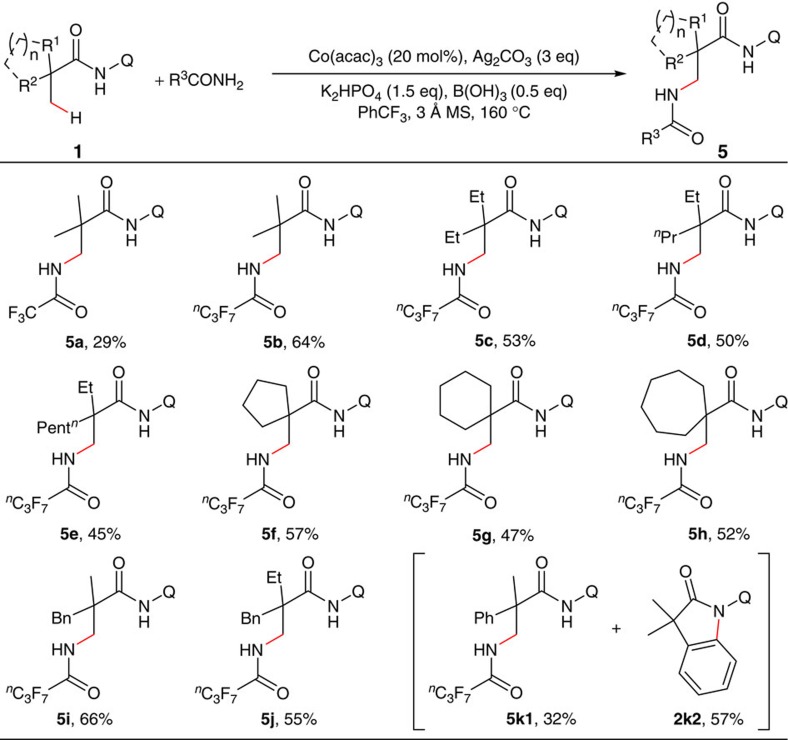
Intermolecular amination of α,α-disubstituted propanamides.Reaction conditions: 1 (0.15 mmol), amide (0.45 mmol), Co(acac)3 (0.03 mmol), Ag2CO3 (0.45 mmol), K2HPO4 (0.23 mmol), B(OH)3 (0.075 mmol), 2.0 ml PhCF3, 160 °C, 24 h. Isolated yield based on three runs of each reaction.